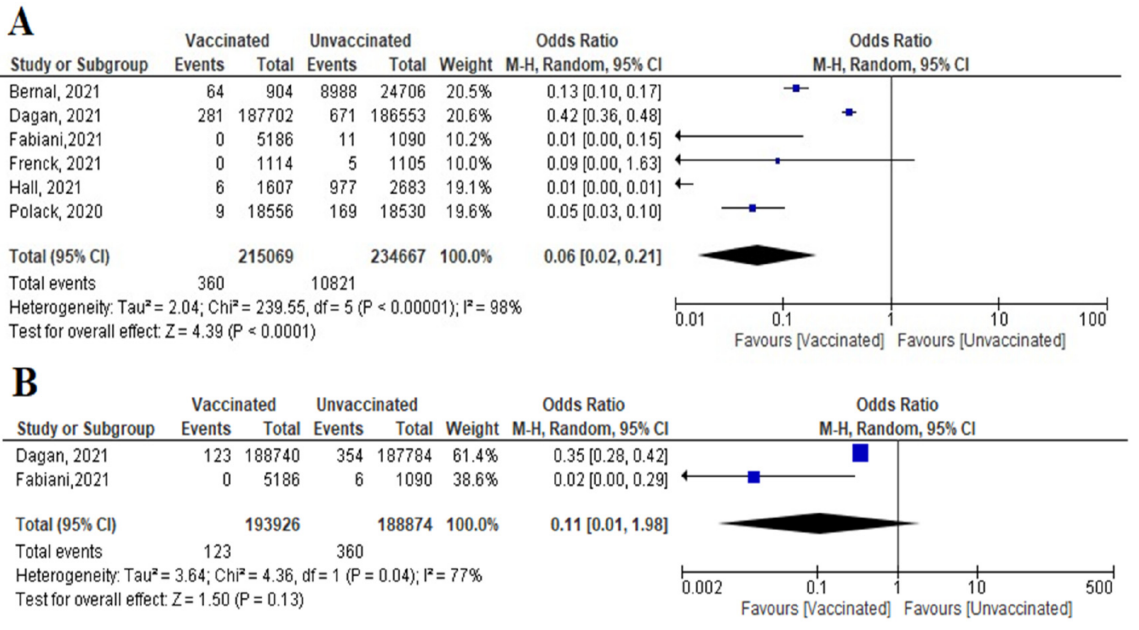
Figure 9. ( A ) Incidence of SARS-CoV-2 infection either symptomatic or asymptomatic within 7 days of 2nd dose of vaccination. ( B ) Incidence symptomatic SARS-CoV-2 within 7 days of 2nd dose of vaccination.